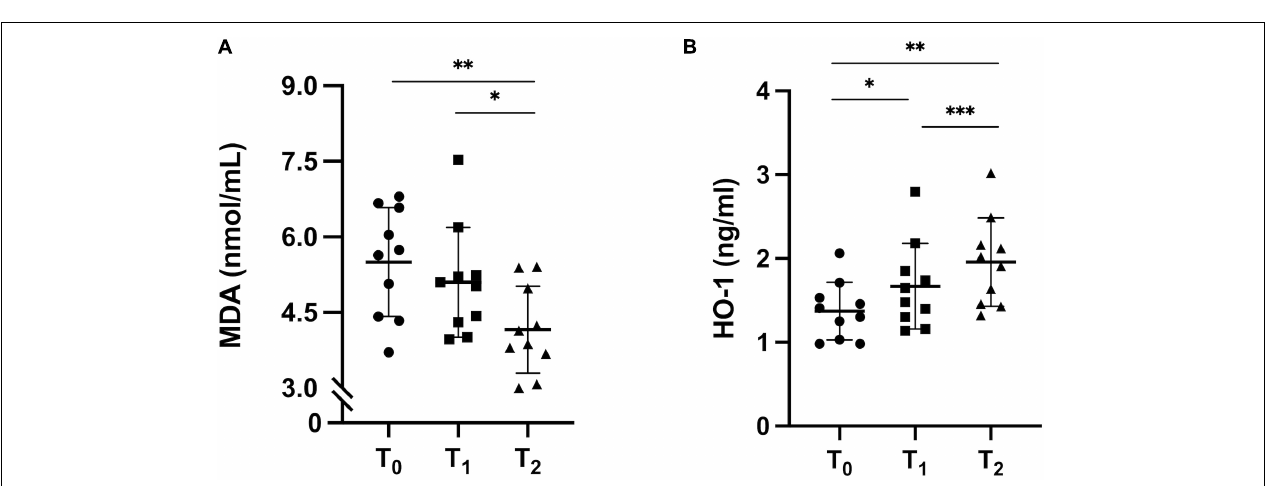
FIGURE 3 | (A) Lipid peroxidation state. Fluorometric analysis of MDA concentration in FD patients before ERT (T 0 ), after 12 months of ERT treatment (T 1 ) and after 6 months of green tea on top of ERT (T 2 ). T 0 vs. T 1 p = ns; T 1 vs. T 2 , * p = 0.03; T 0 vs. T 2 , ** p = 0.005. ANOVA, p = 0.004. (B) HO-1 protein expression in FD patients at T 0 , at T 1 and at T 2 . T 0 vs. T 1 , * p = 0.04; T 0 vs. T 2 , ** p = 0.001; T 1 vs. T 2 , *** p < 0.001. ANOVA, p =